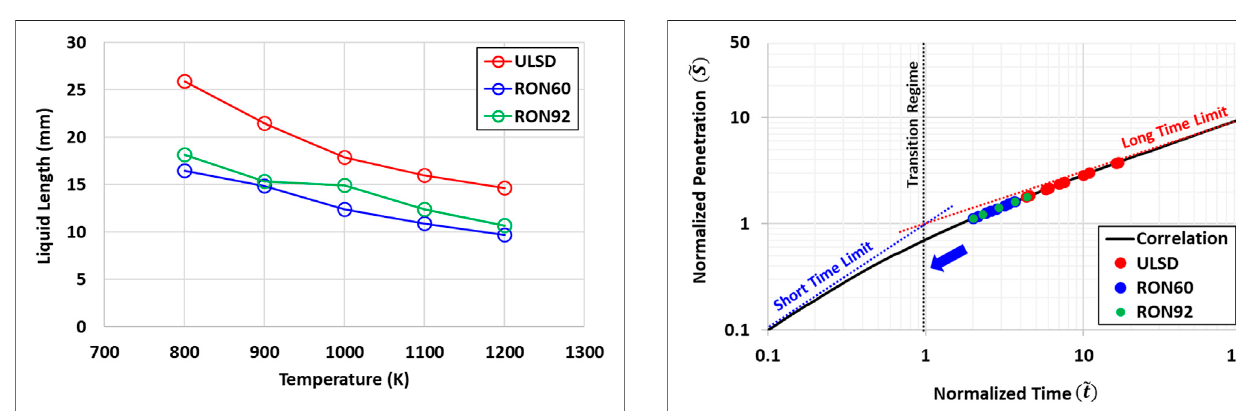
FIGURE 25 | Normalized liquid penetration data under vaporizing